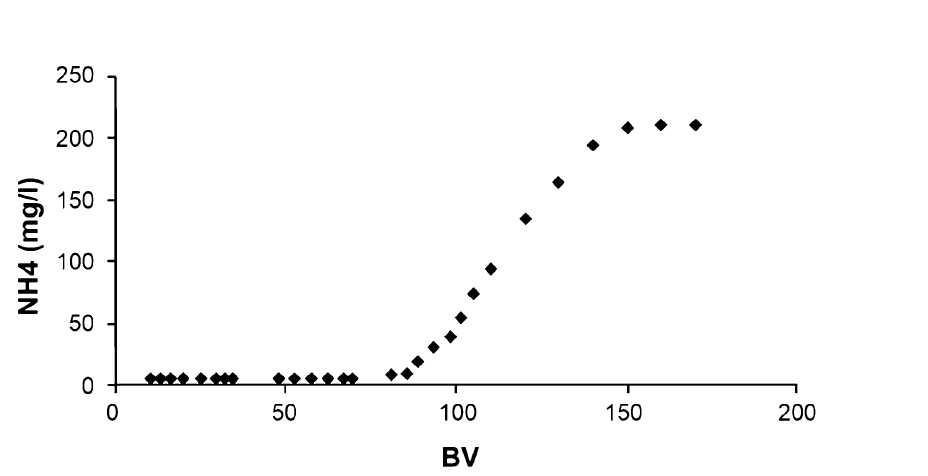
Figure 4. NH 4+ (mg/l) vs number of liters of water passing through the experimental column. BV = ratio between the volume of solution and the volume of zeolitite.